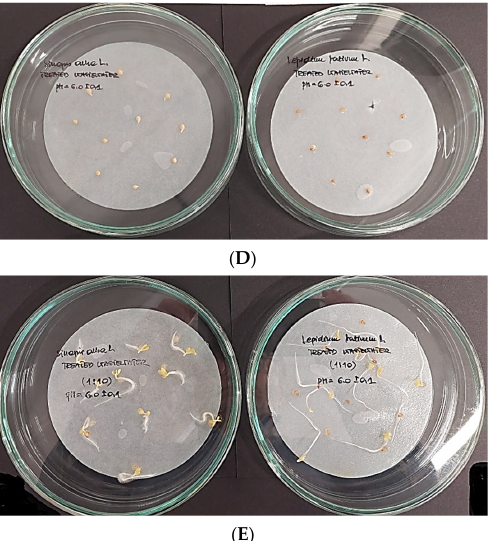
Figure 5. Phytotoxicity test results for S. alba and L. sativum L. (from left to right); blank—distilled water ( A ), raw wastewater, pH 6.0 ± 0.1 ( B ), raw wastewater (1:10), pH 6.0 ± 0.1 ( C ), treated wastewater pH 6.0 ± 0.1 ( D ), treated wastewater (1:10) pH 6.0 ± 0.1 ( E ).